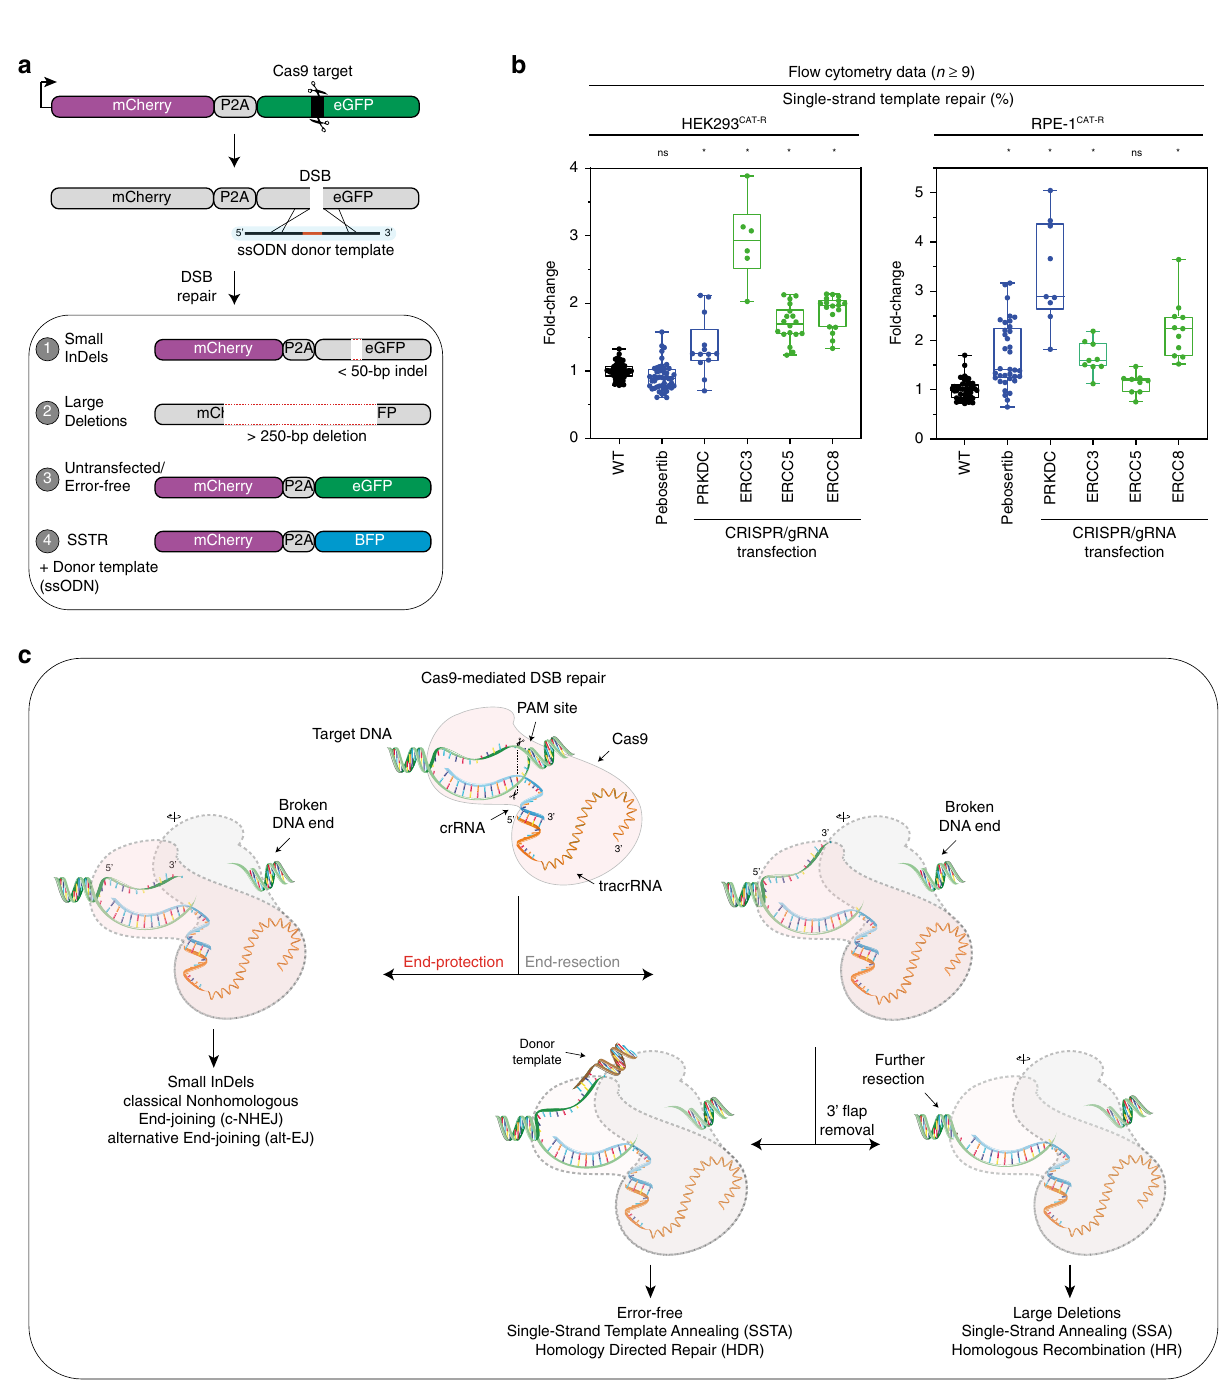
Fig. 5 Knocking-out NER increases the chances of a successful knock-in. a Representation of the CAT-R reporter with the use of an external donor template as a ssODN. The ssODN bears the necessary nucleotide changes to convert GFP to a BFP indicating a single-strand template repair (SSTR) event. b A box and whiskers plot (For HEK293 CAT-R : n WT = 79, n M3814 = 48, n PRKDC = 13, n ERCC3 = 9, n ERCC5 = 18, n ERCC8 = 18; for RPE-1 CAT-R : n WT = 45, n pebosertib = 36, n PRKDC = 9, n ERCC3 = 9, n ERCC5 = 9, n ERCC8 = 11, centerlines mark the medians, box limits indicate the 25th and 75th percentiles, and whiskers extend to min and max, showing all points) presenting the frequency of conversion of GFP to BFP with the use of an asymmetric ssODN template in a mixed pool CRISPR/gRNA transfected cells. Values are represented as fold change to wildtype (WT) control, * p < 0.05 versus WT control, multiple comparison analysis testing in ANOVA followed by a Dunnett ’ s test. All individual p -values are included in Source Data fi le 3. Data are derived from a minimum of three independent experiments; n represents the number of all replicates. c Proposed mechanism of Cas9-mediated DSB repair choice. Once a Cas9-mediated DSB occurs, end protection mechanisms or alt-EJ will act to favor a quick ligation and thus form small InDels. If the damage is not repaired, then end resection mechanisms will start resecting the region leading to large deletions. Due to the nature of Cas9-mediated DSB, a 3 ′ fl ap is created, and it is possibly removed with the help of NER components. If this 3 ′ fl ap is not removed, then it favors a more ef fi cient